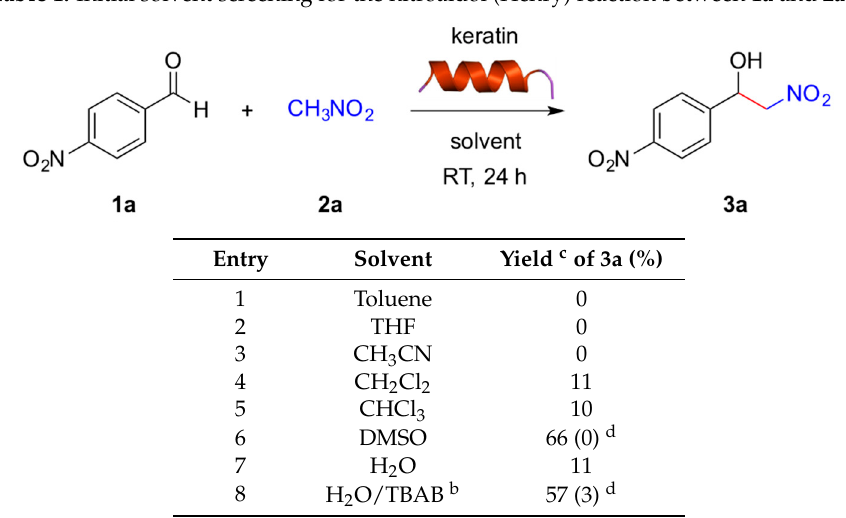
Table 1. Initial solvent screening for the nitroaldol (Henry) reaction between 1a and 2a a .